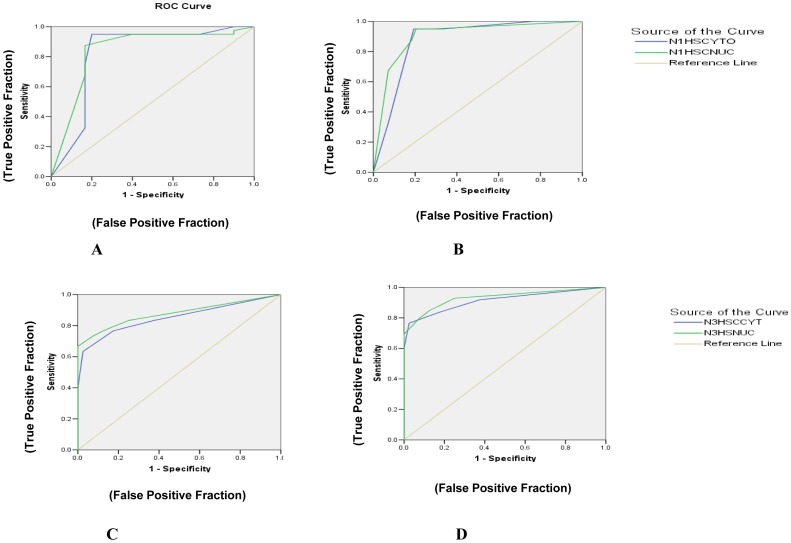
(A-D) Receiver operating characteristic curves of Notch-1(A, B) and Notch-3(C, D, nuclear and cytoplasmic) in normal vs. precancer (A, C) and ISCC (B, D).Blue line shows ROC analysis for cytoplasmic Notch-1/Notch-3. Green line shows ROC analysis for nuclear Notch-1/Notch-3 respectively. Y-axis of the plot shows true-positive fraction and X-axis shows false positive fraction.